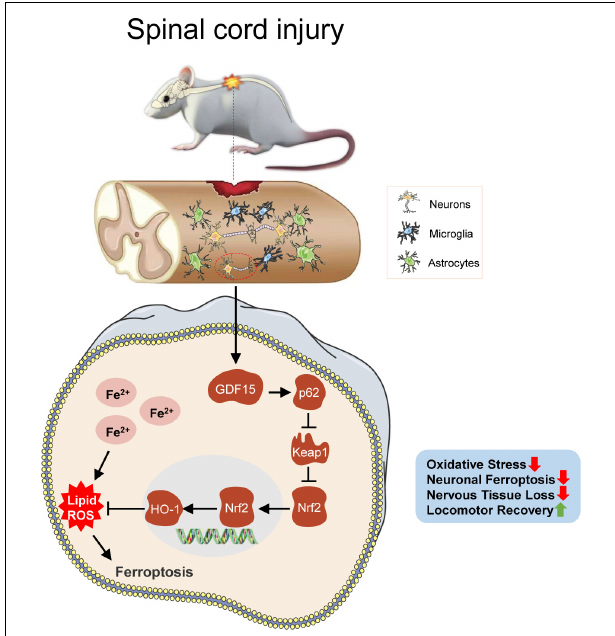
FIGURE 7 | GDF15 alleviates SCI-induced neuronal ferroptosis by regulating the p62-Keap1-Nrf2 signaling pathway. After SCI, cracked blood vessels at the injured cords result in the lysis and destruction of erythrocytes, which release a large amount of iron. Excessive iron accumulated in neurons produces superfluous ROS and causes neuronal ferroptosis, which promotes the activation of the p62-Keap1-Nrf2 signaling pathway. Besides, GDF15 in neurons further facilitates the activation of the p62-Keap1-Nrf2 pathway by stabilizing p62 and increased Nrf2 and HO-1 inhibit the accumulation of ROS and thus alleviate neuronal ferroptosis. GDF15 is suggested as a potential target on mitigating nervous tissue loss and promoting locomotor recovery post